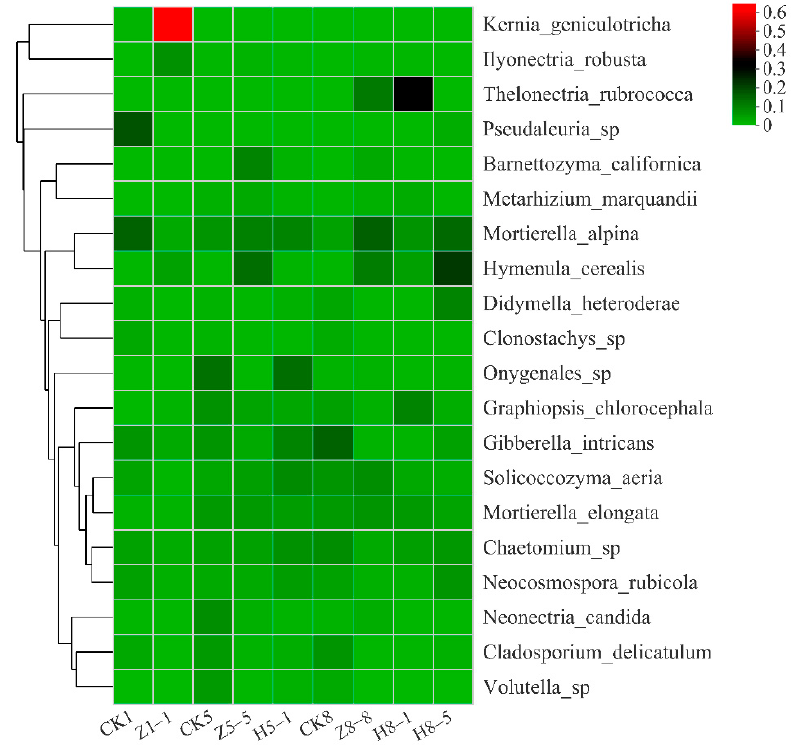
Figure 6. Heat map of fungi species with top 20 relative abundances in the soil in different years of growing and replanting. Note: The nomenclature for each sample is the same as that in Table 2.